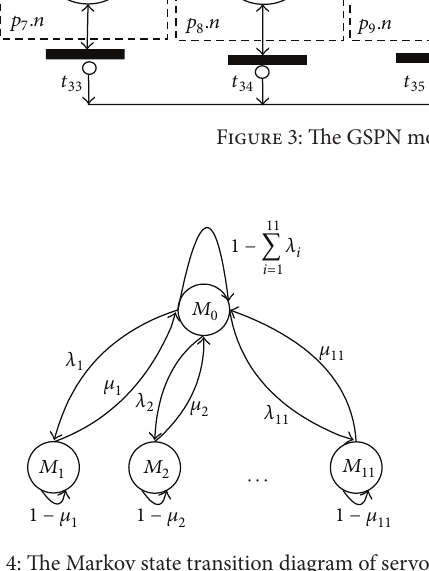
Figure 4: The Markov state transition diagram of servo